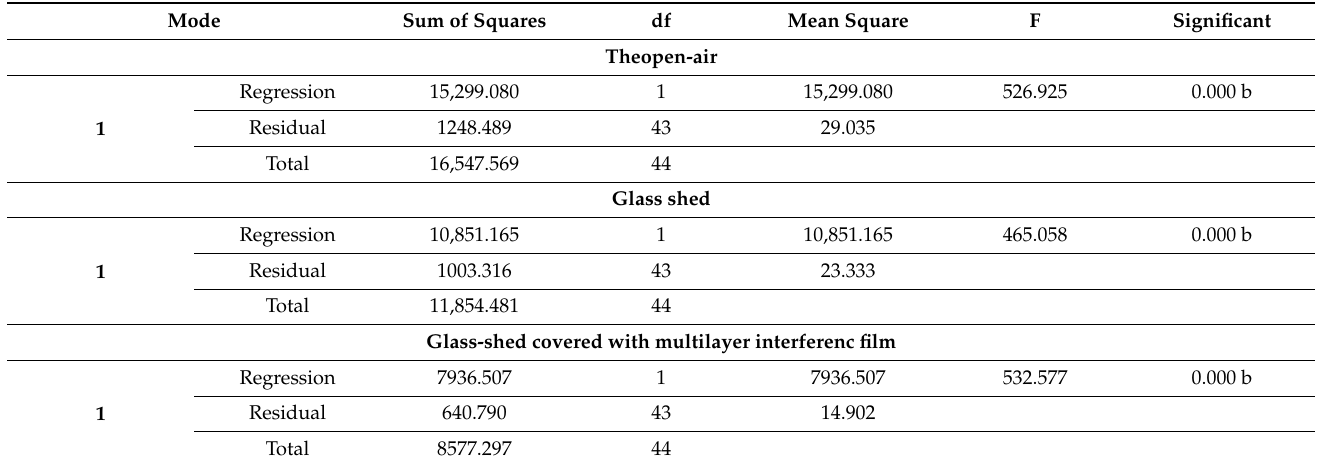
GS, and GMF. Table 2. The output of the SPSS shows the model Summary (b) of the three treatments.